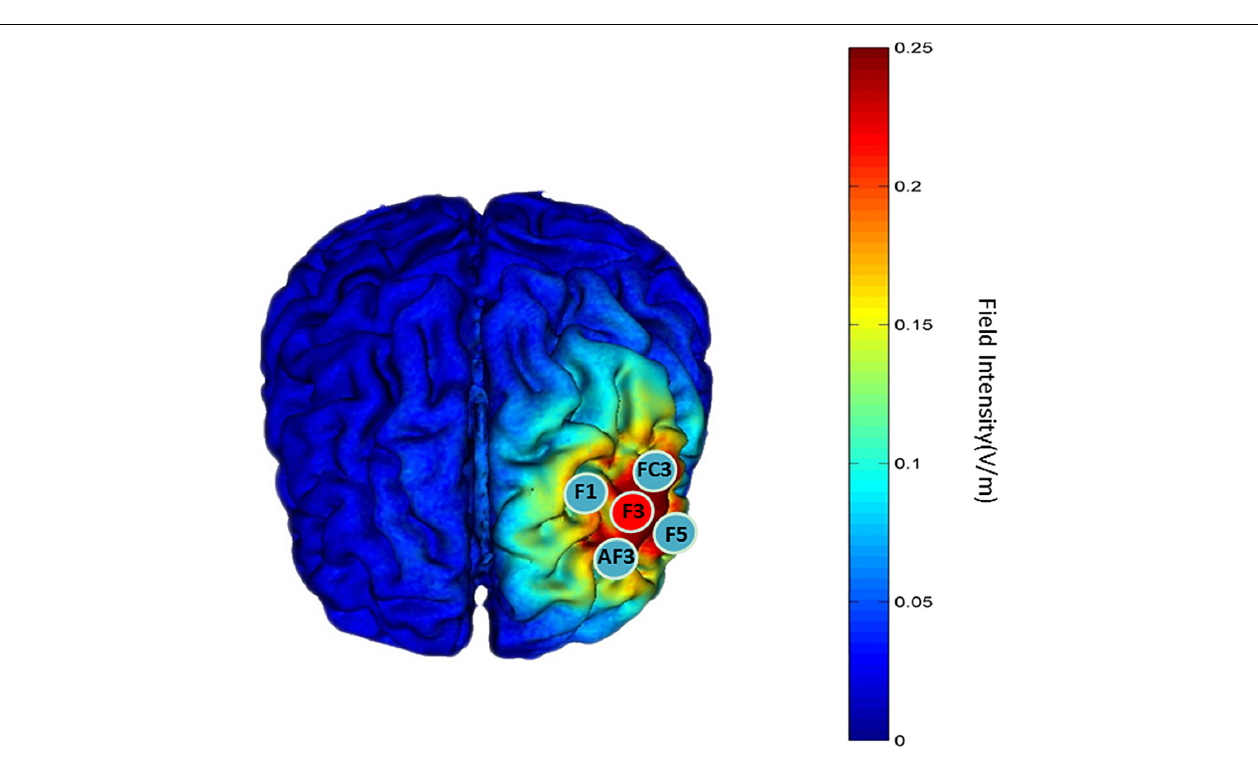
FIGURE 4 | “Red patch” indicates the position of the anodal electrode. “Blue patch” indicates the position of the cathodal electrode. The theoretical current intensity at the cortex (left DLPFC) of the tDCS electrode array was calculated using Soterix